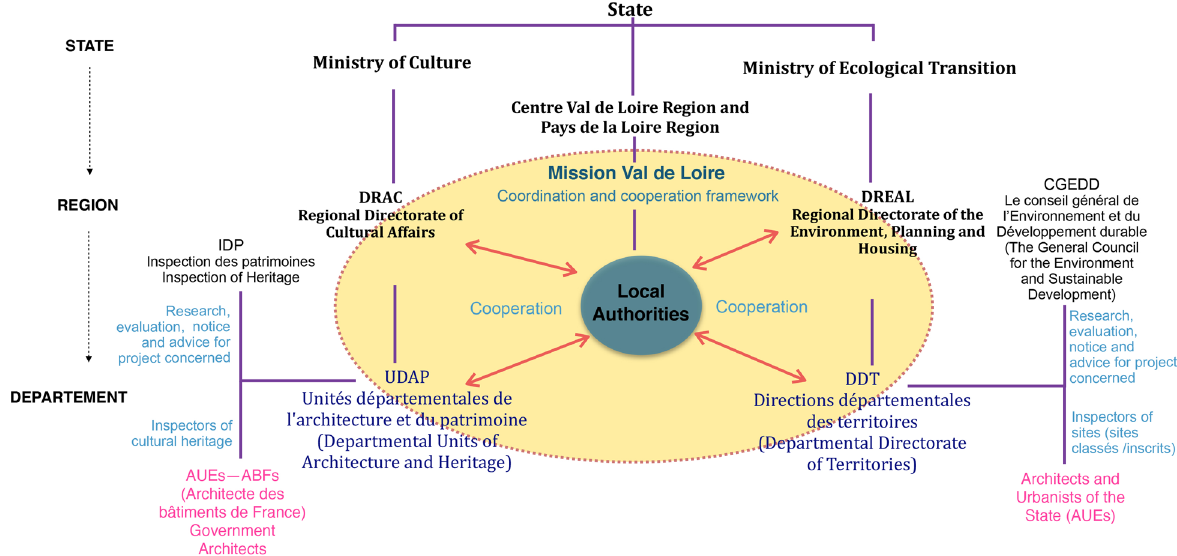
Fig. 5 Cooperation and coordination system of the Loire Valley management (Source: Liang